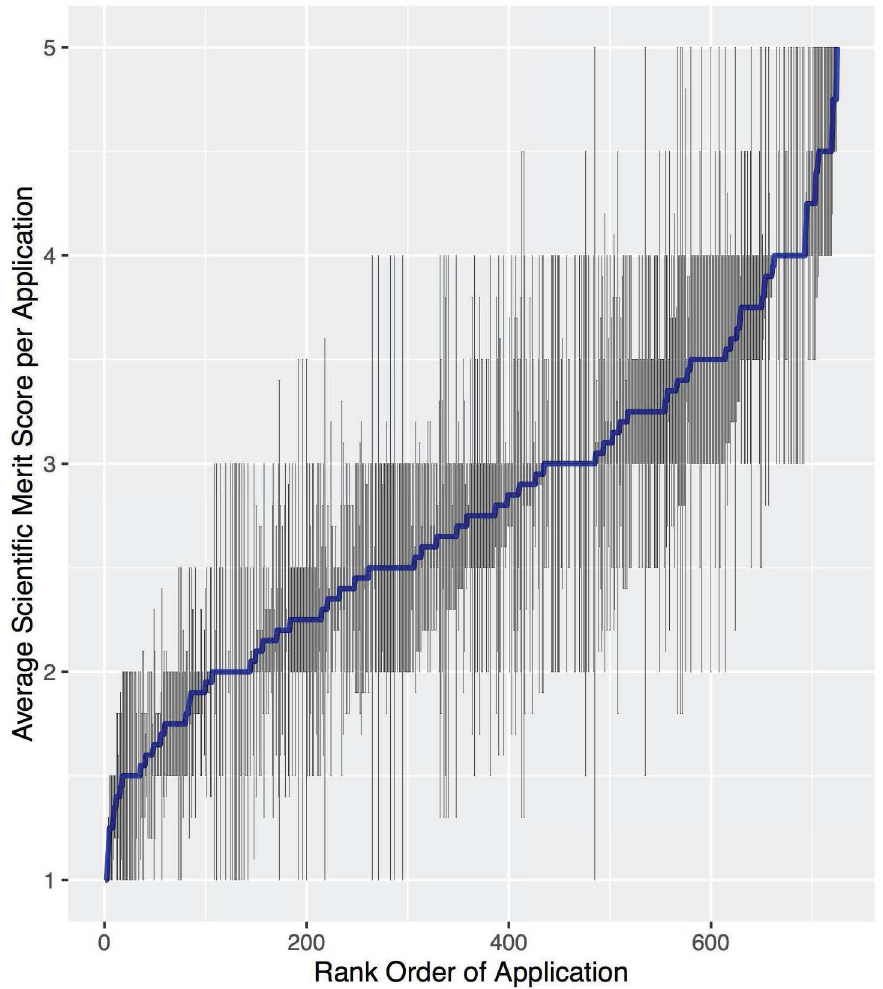
Fig 1. Average SM Score per Application. Average SM score for each application versus the rank order by averageSM score, with error bars representing standard error (2009–2012).